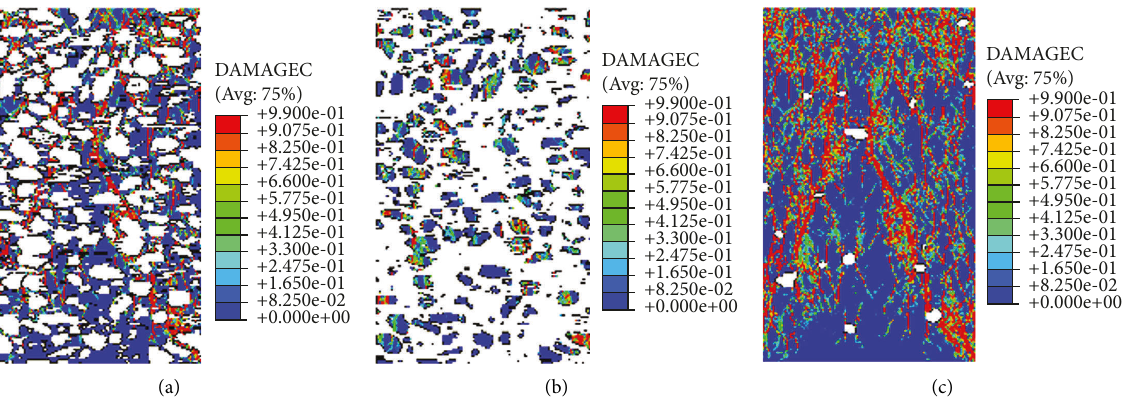
Figure 17: Damage graphs of different materials when the loading displacement is 1mm. (a) Mortar. (b) Aggregate. (c) Concrete.